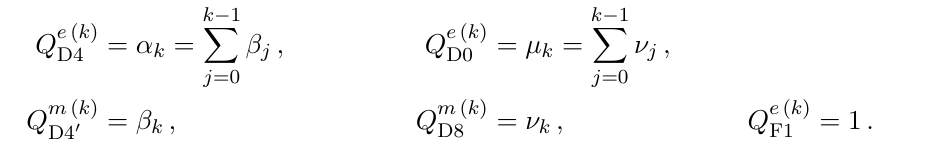
behaviour of the solutions at both ends of the space is compatible with the presence of O8 orientifold fixed points. These could provide for a fully consistent brane picture.